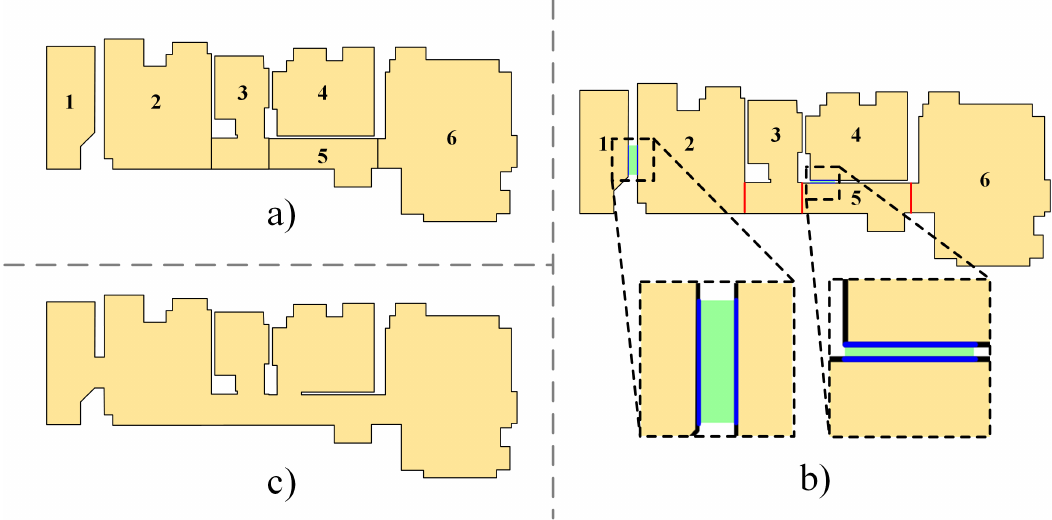
Figure 18. The process of sub-contour mergence: ( a ) Initial mergence of sub-contours (1–6 indicate the extracted sub-contours), ( b ) merging refinement (enlarged to show the connections between sub-contours), ( c ) the result of contour extraction (red lines: Virtual connection walls; blue lines: Wall vacancies; green rectangles: The extracted